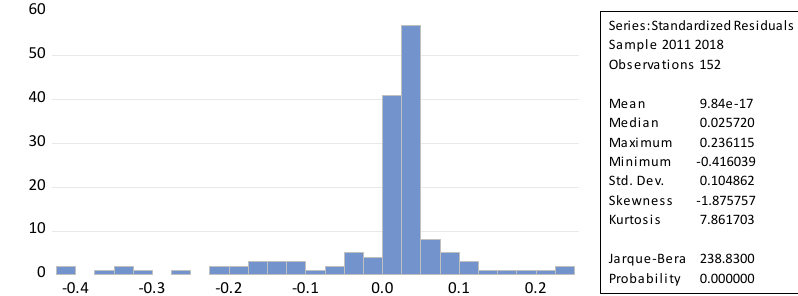
Figure 4. Test of normality of error terms in the third